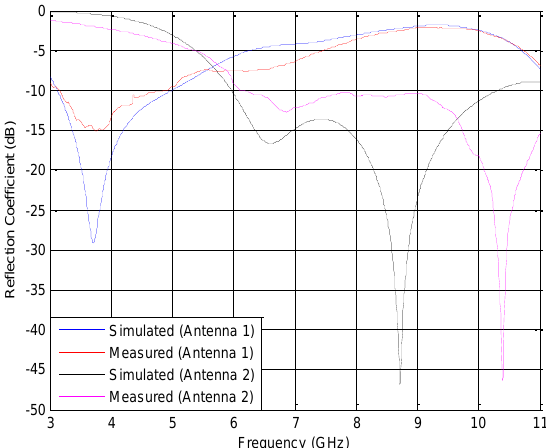
Fig. 11 : Reflection coefficient of the combined antenna.